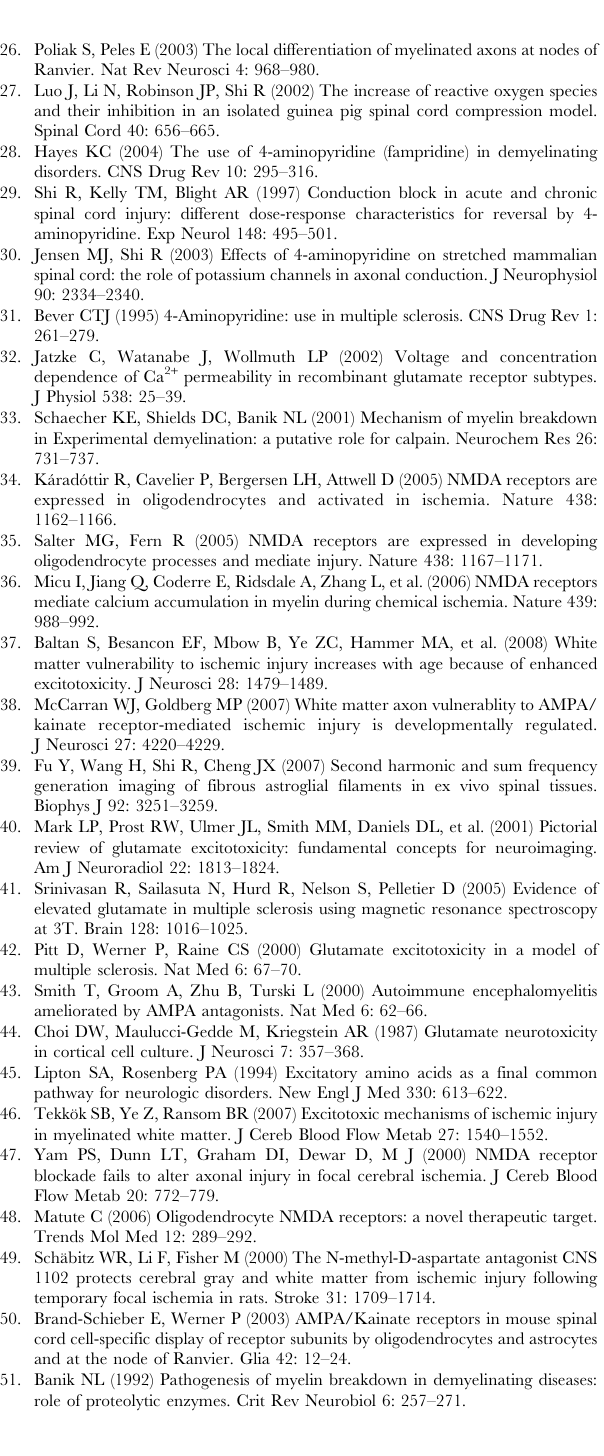
Table S1 Analysis of ratios of nodal length to nodal diameter in spinal cord treated with glutamate in vivo